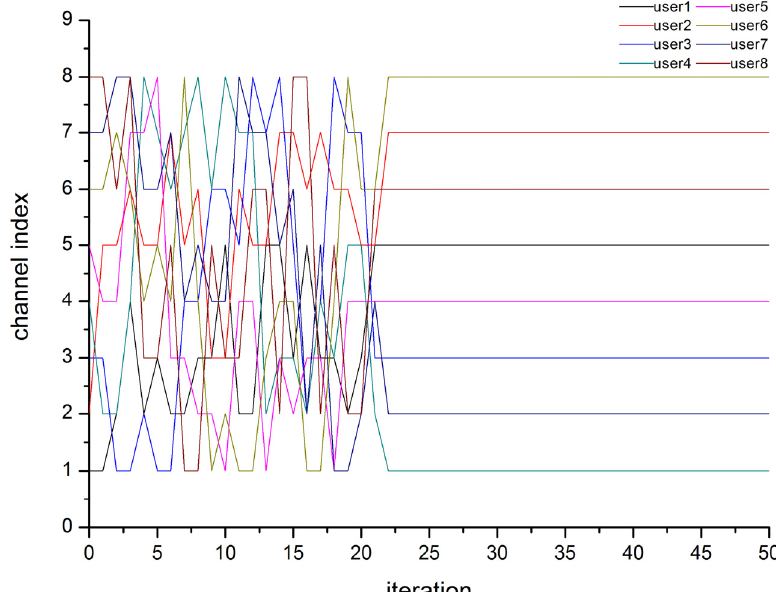
Figure 9. The simulation results of proposed CR spectrum allocation algorithm based on non-cooperative game theory with eight channels.